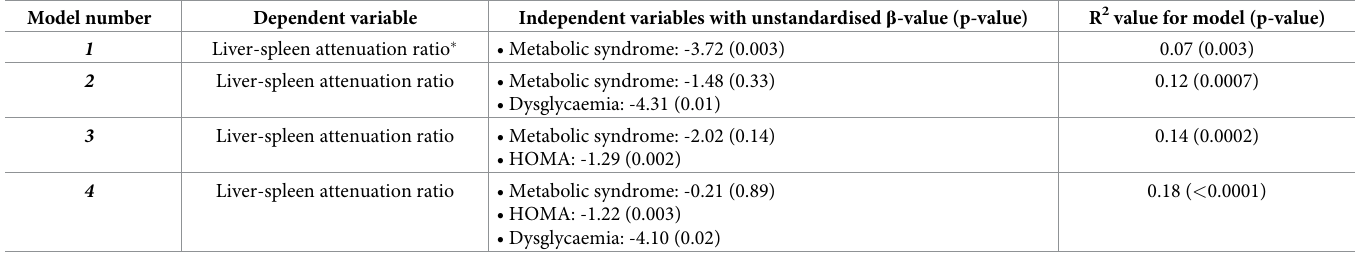
Table 4. Multiple linear regression analysis for the identification of factors that attenuate the relationship between hepatic fat content and metabolic syndrome. Model